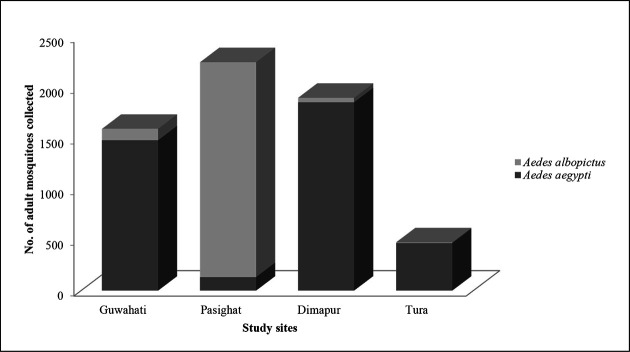
Graphical representation of distribution of Ae. aegypti and Ae. albopictus in the four study sites.